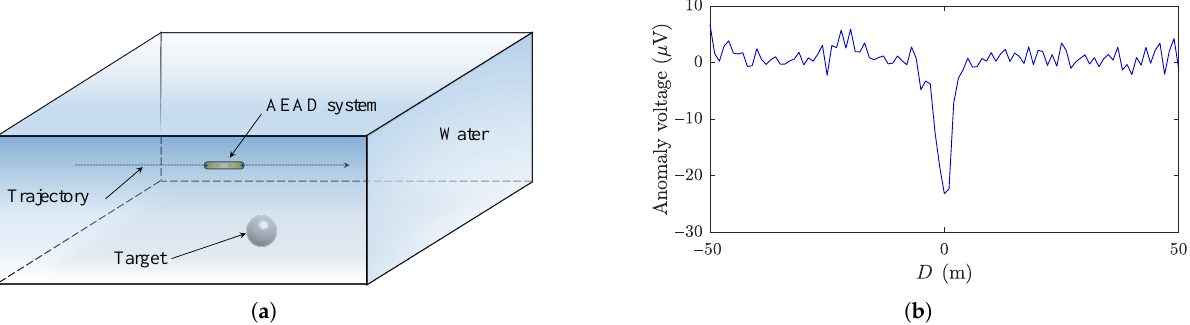
Figure 7. The CST simulation experiment. ( a ) The experimental simulation setup. ( b ) The electric anomaly